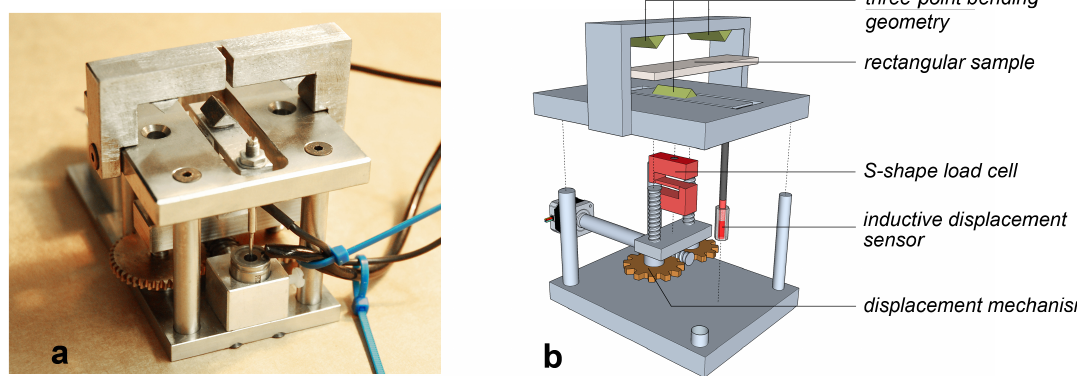
Figure 3. ( a ) Stress relaxation setup; ( b ) and its detailed diagram.